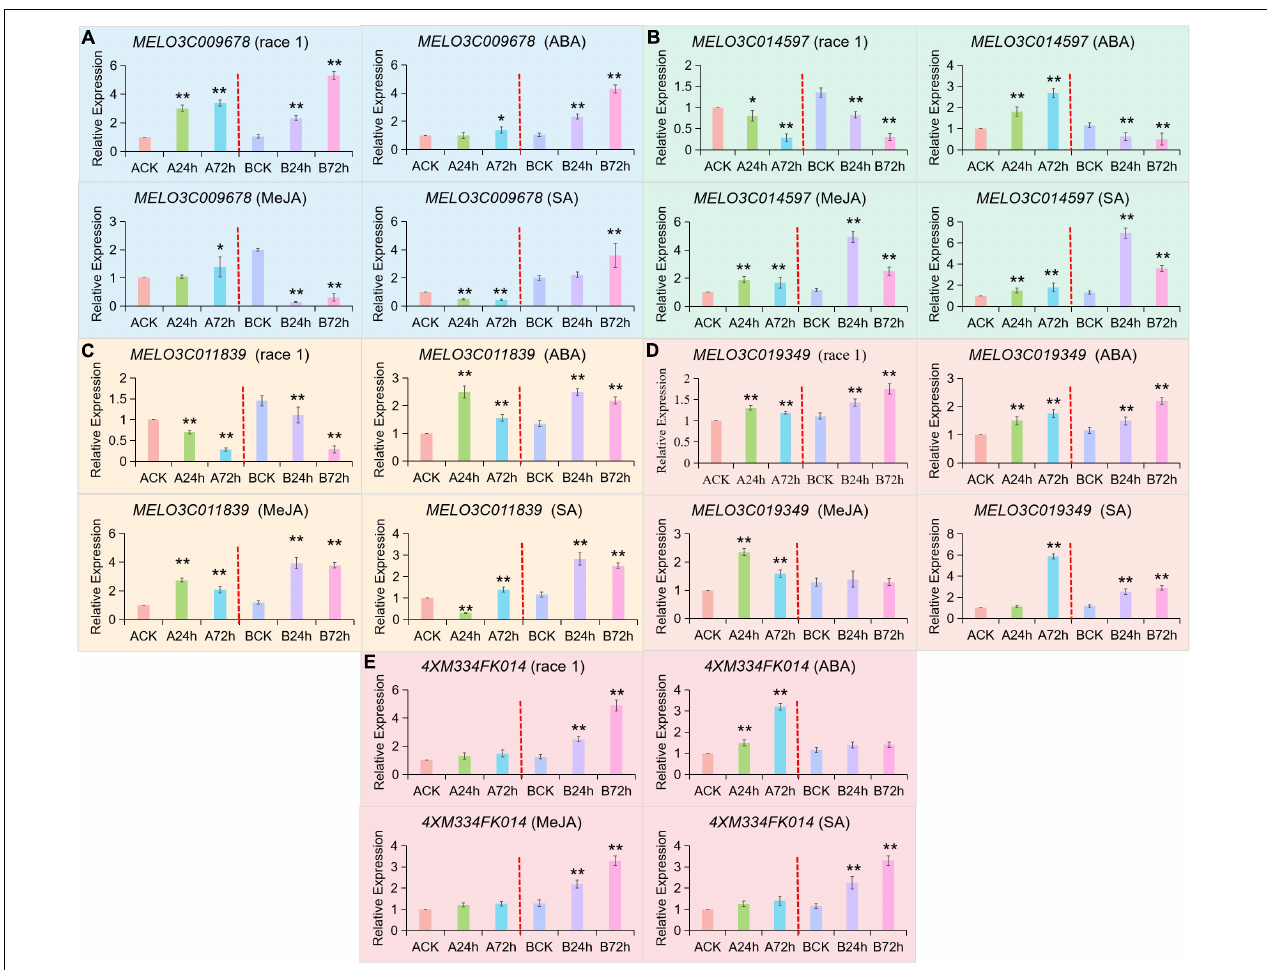
FIGURE 7 | qRT-PCR validation for candidate genes regulating Fom-2 activity. Asterick symbols (*, **) are representing the significant results at ** p < 0.01 and * p < 0.05 levels, respectively. Expression of five candidate genes (A) MELO3C009678, (B) MELO3C014597, (C) MELO3C011839, (D) MELO3C019349, (E) 4XM334FK014, at different periods of exogenous spraying induction of f. oxysporum (Race 1), ABA, MeJA, and SA,